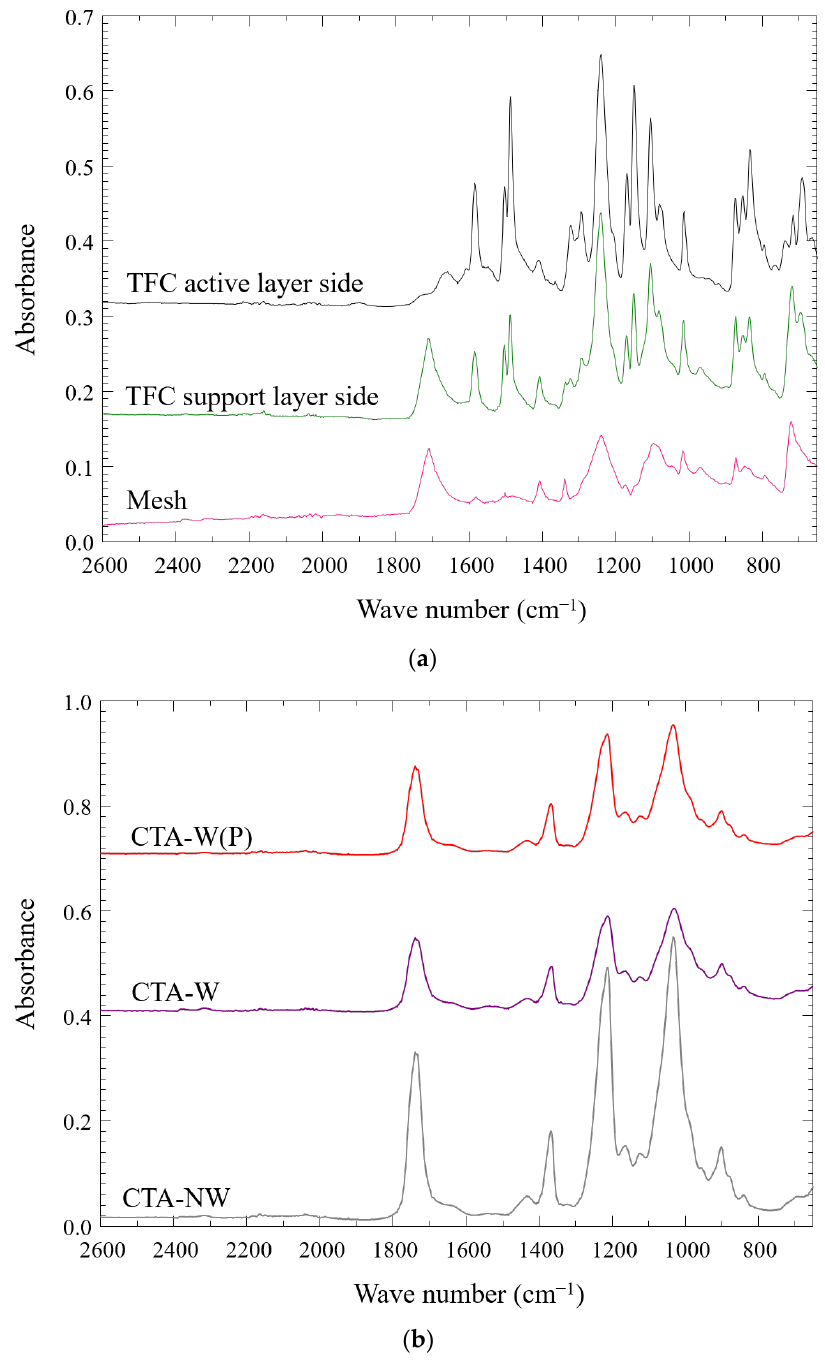
Figure 3. Fourier transform infrared spectroscopy (FTIR) spectra of ( a ) TFC, and ( b ) CTA-W(P), CTA-woven (W), and CTA-nonwoven (NW) membranes. Table 1. The chemical property, structural property, and intrinsic separation property of membranes.